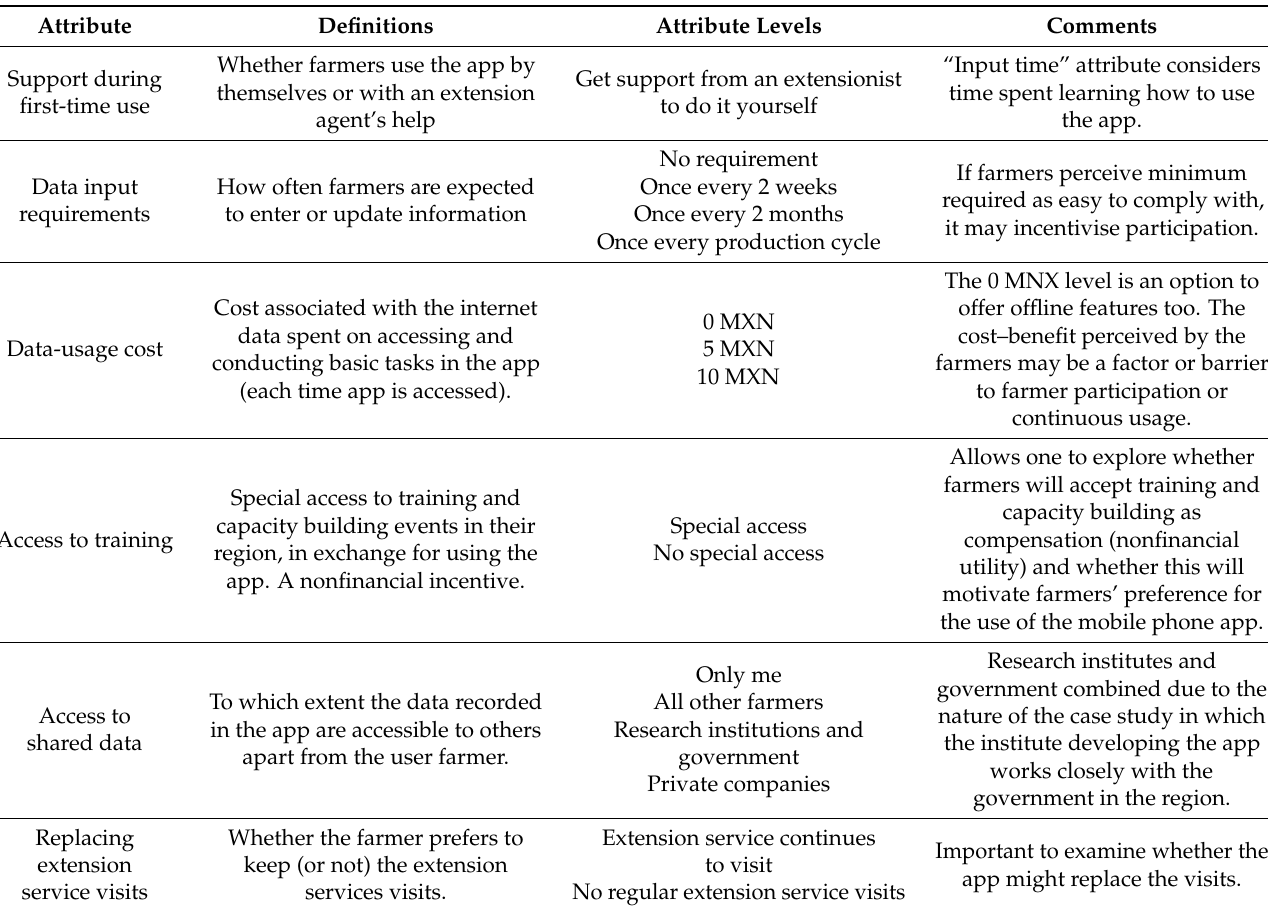
Table 1. Attributes and levels for the choice experiment on an app for